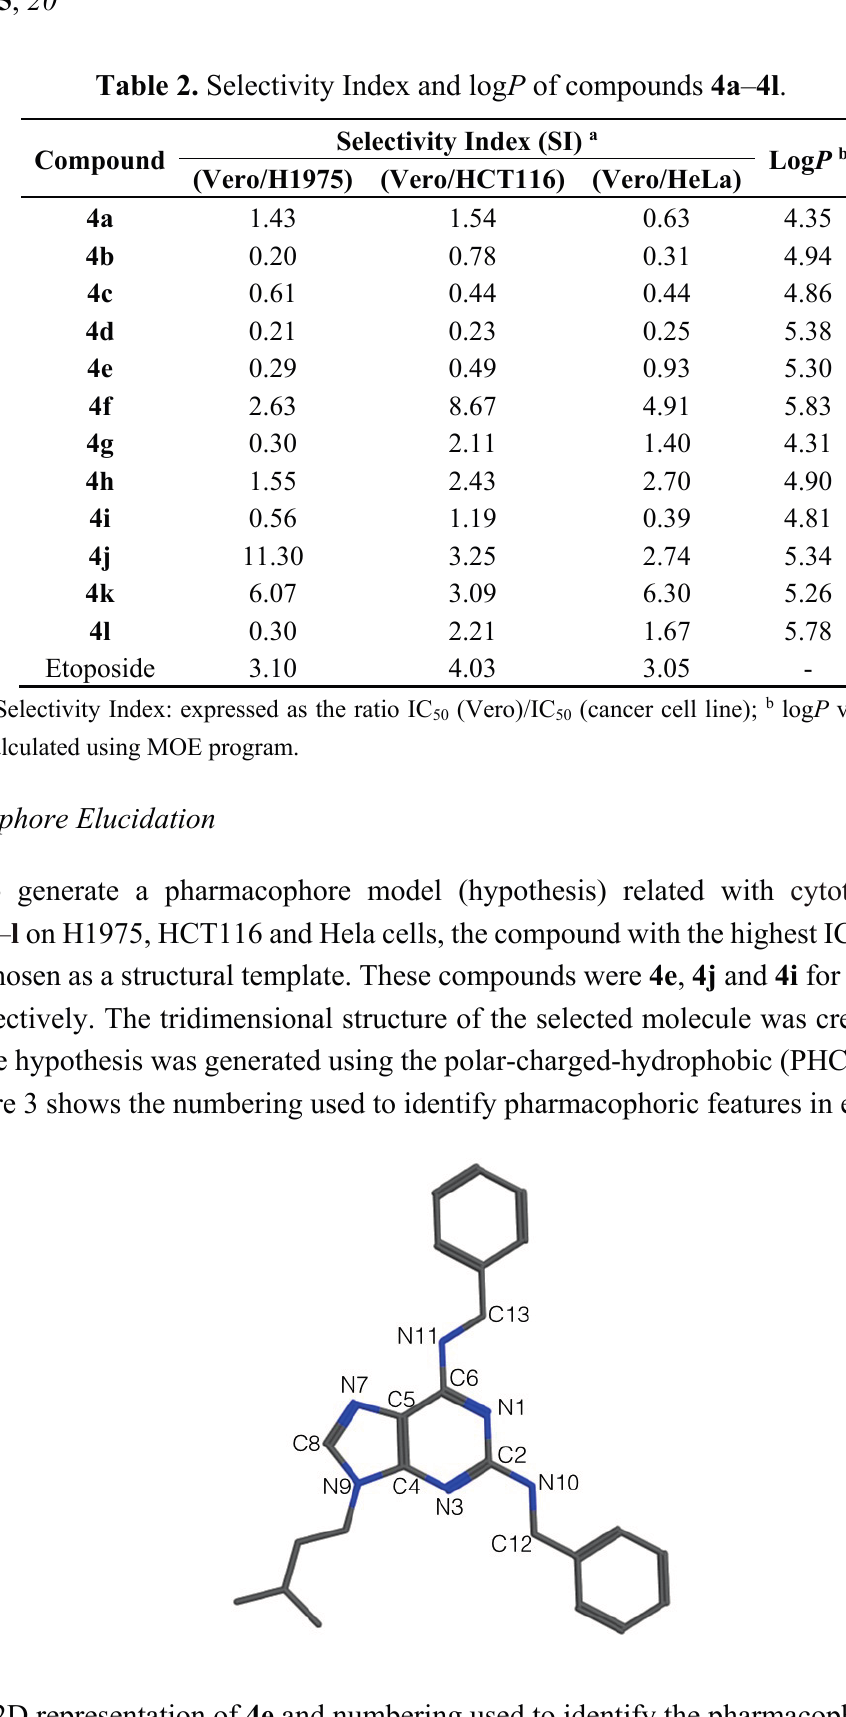
Figure 3. 2D representation of 4e and numbering used to identify the pharmacophoric